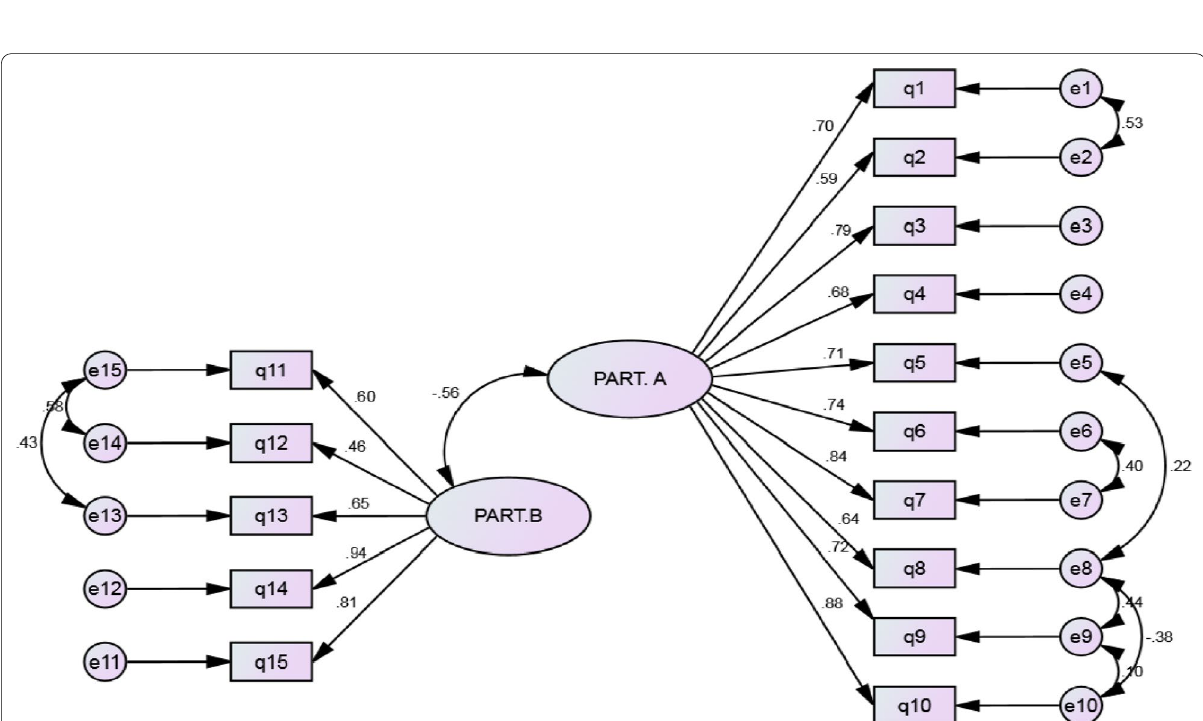
QoR-15: Quality of recovery; CFA: confirmatory factor analysis; CMIN/DF: Chi-square/degree-of-freedom ratio; RMSEA: Root Mean Square Error of Approximation; PCFI: Parsimonious Comparative Fit Index; PNFI: Parsimonious Normed Fit Index; AGFI: Adjusted Goodness-of-Fit Index; IFI: Incremental Fit Index; CFI: Comparative Fit Index